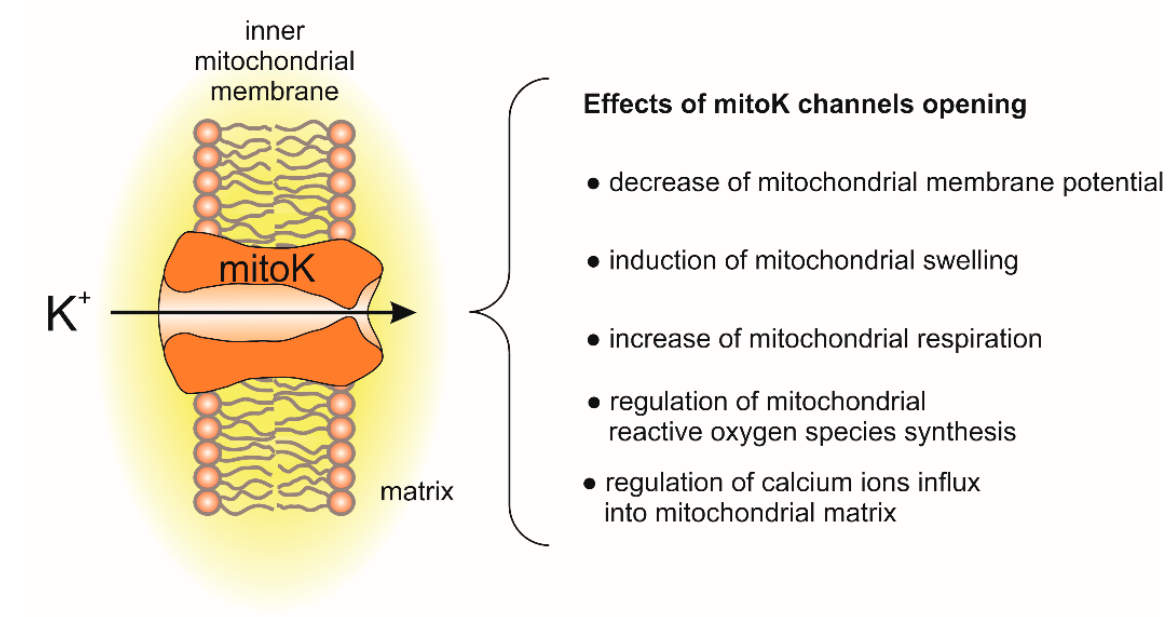
Figure 1. Effects of mitochondrial potassium channel opening on mitochondrial functions.